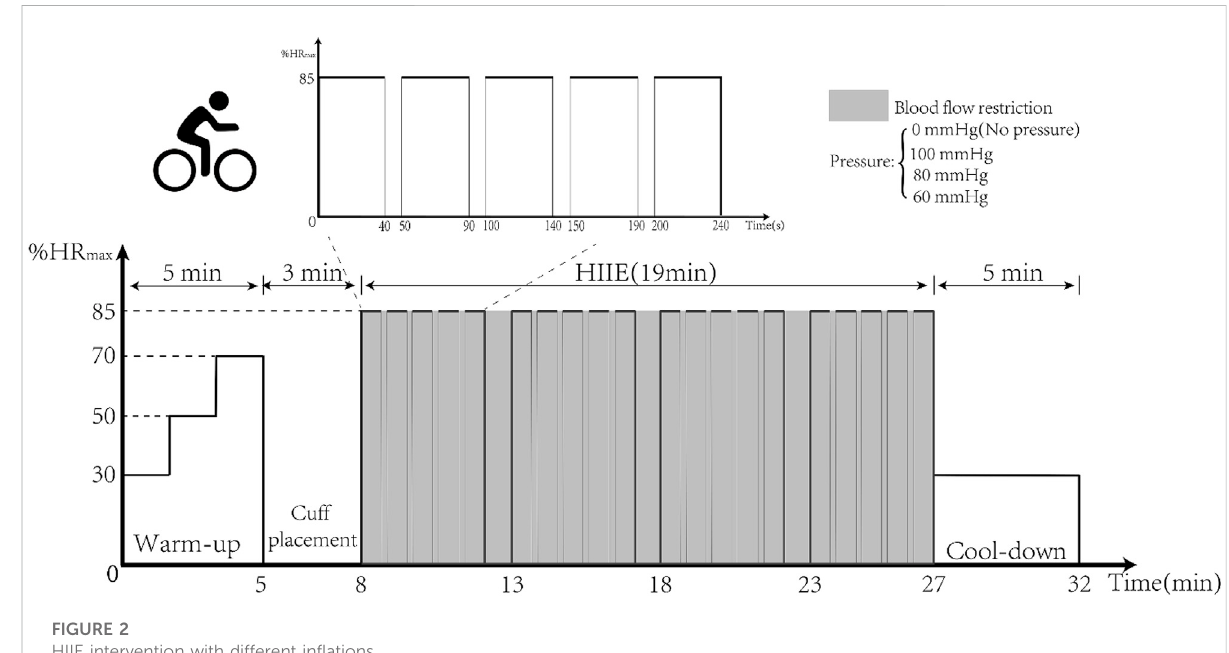
FIGURE 2 HIIE intervention with different in fl ations.